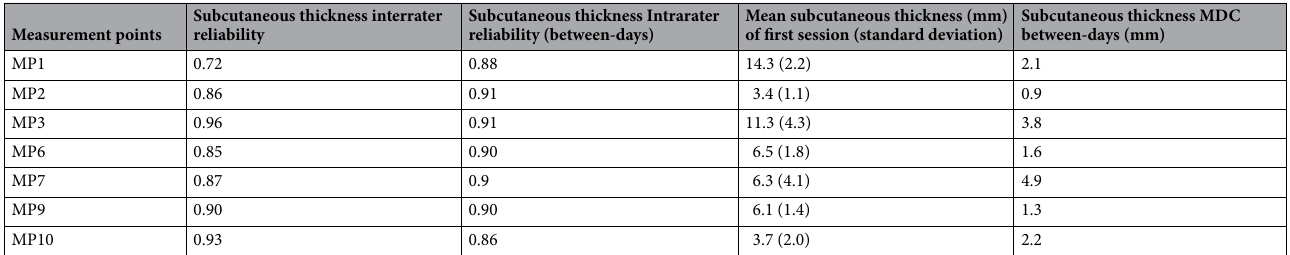
Table 4. Ultrasound imaging subcutaneous thickness results for interrater and intrarater (between-days) reliability, mean subcutaneous thickness, and minimal detectable change. MP1 Plantar Fascia, MP2 Achilles tendon, MP3 Soleus, MP6 Splenius capitis, MP7 Anterior Deltoid, MP9 Patellar tendon, MP10 Anterior tibialis.